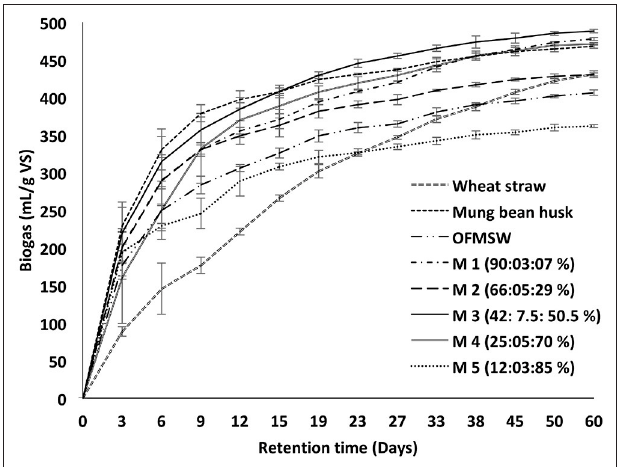
FIGURE 5 | Accumulative biogas production of mixture.